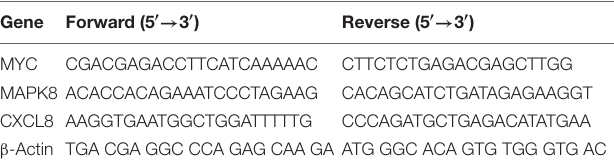
TABLE 3 | Real-time quantitative PCR primers used in this